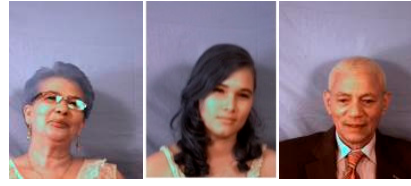
Figure 16. Samples of face with high reflected regions.